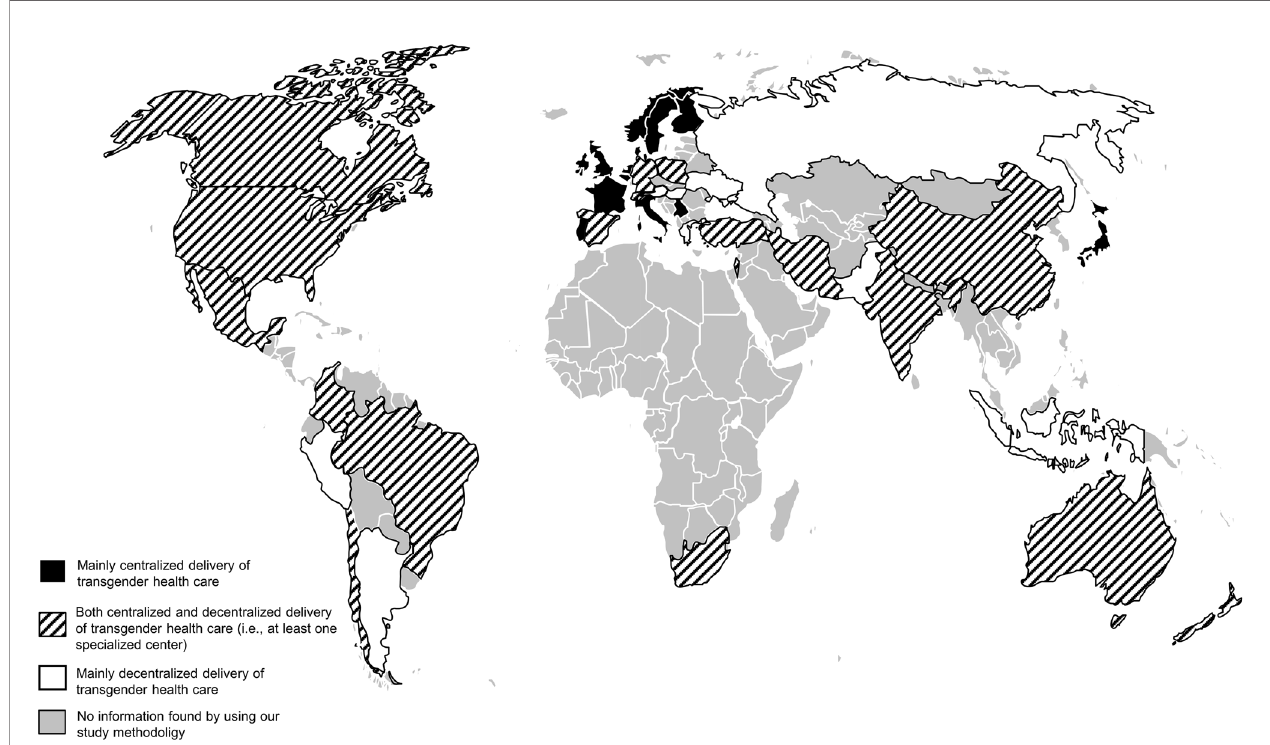
FIGURE 3 | Transgender health care delivery